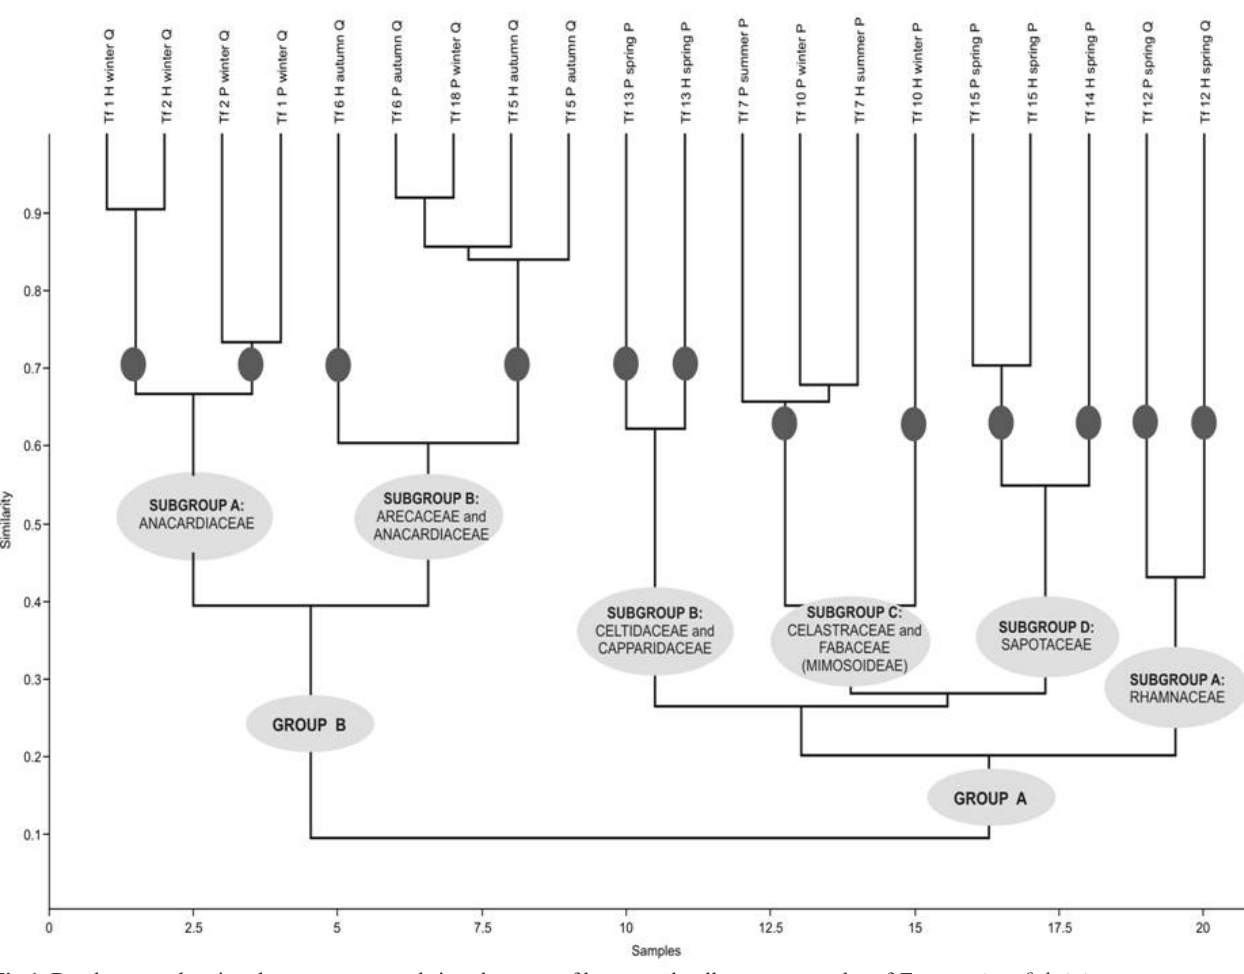
Fig 1 . Dendrogram showing the two groups and six subgroups of honey and pollen mass samples of Tetragonisca fiebrigi